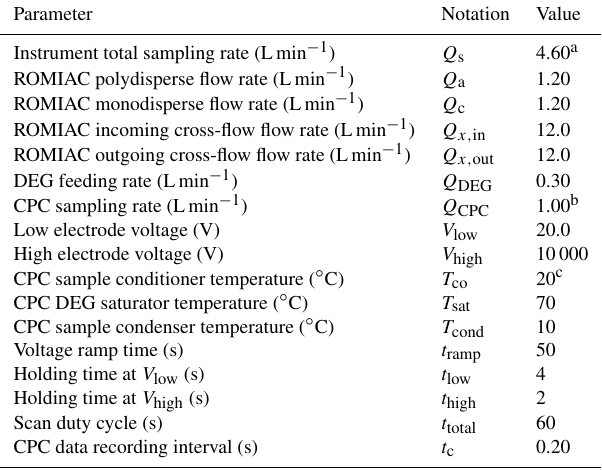
Table 1. Default nSEMS operating parameters optimized for mea- surements of NPF events and nanoparticle growth. These settings enable particle size distribution measurements in the range of 1.5– 25nm, with a duty cycle of 1min and a size classification resolution of R nom,nd =